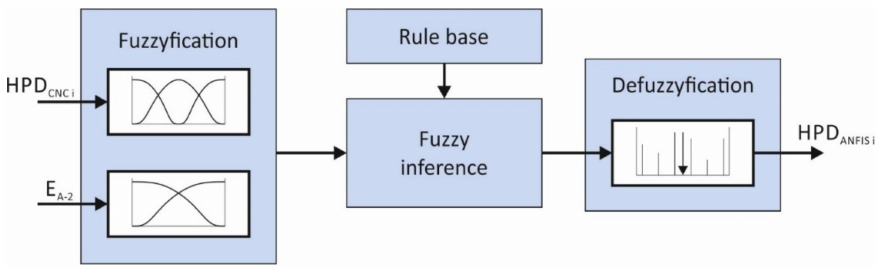
Figure 10. A diagram of a neuro-fuzzy system.